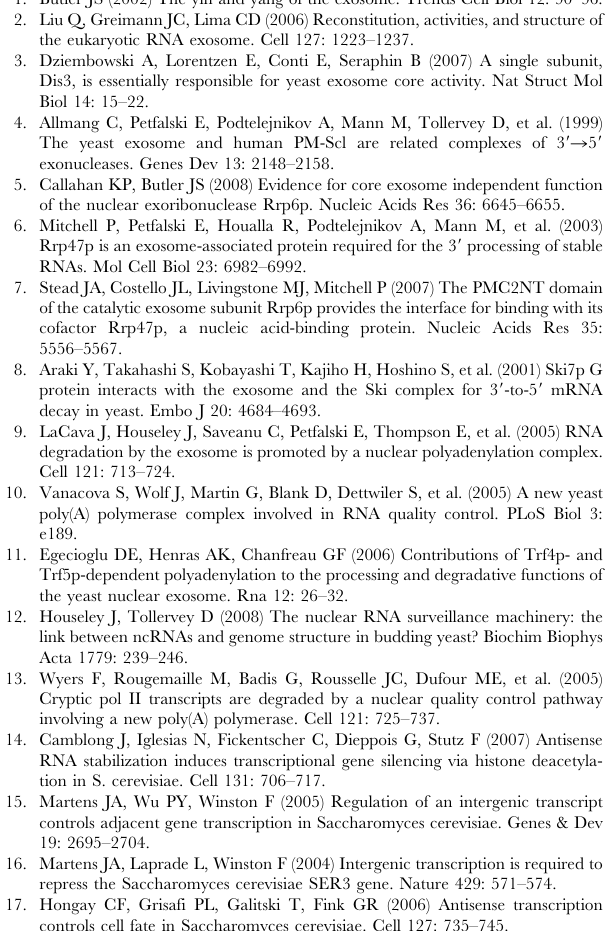
Figure S7 Verification of RNA digestion for total cellular extracts treated with RNAse A. The RNA present in the total protein extracts prepared from not4delta or caf40delta cells expressing tagged Not4 or tagged Caf40 respectively, that were digested or not with RNAse A (see Fig. 7), was analyzed by migration on a 1% agarose gel stained with ethidium bromide. Table S1 The results of the micro-array analyses for all of the snRNAs and snoRNAs present on the ChIPs are indicated, as well as a description of the types of snoRNAs as obtained from the yeast snoRNA database at US Amherst (http://people.biochem.